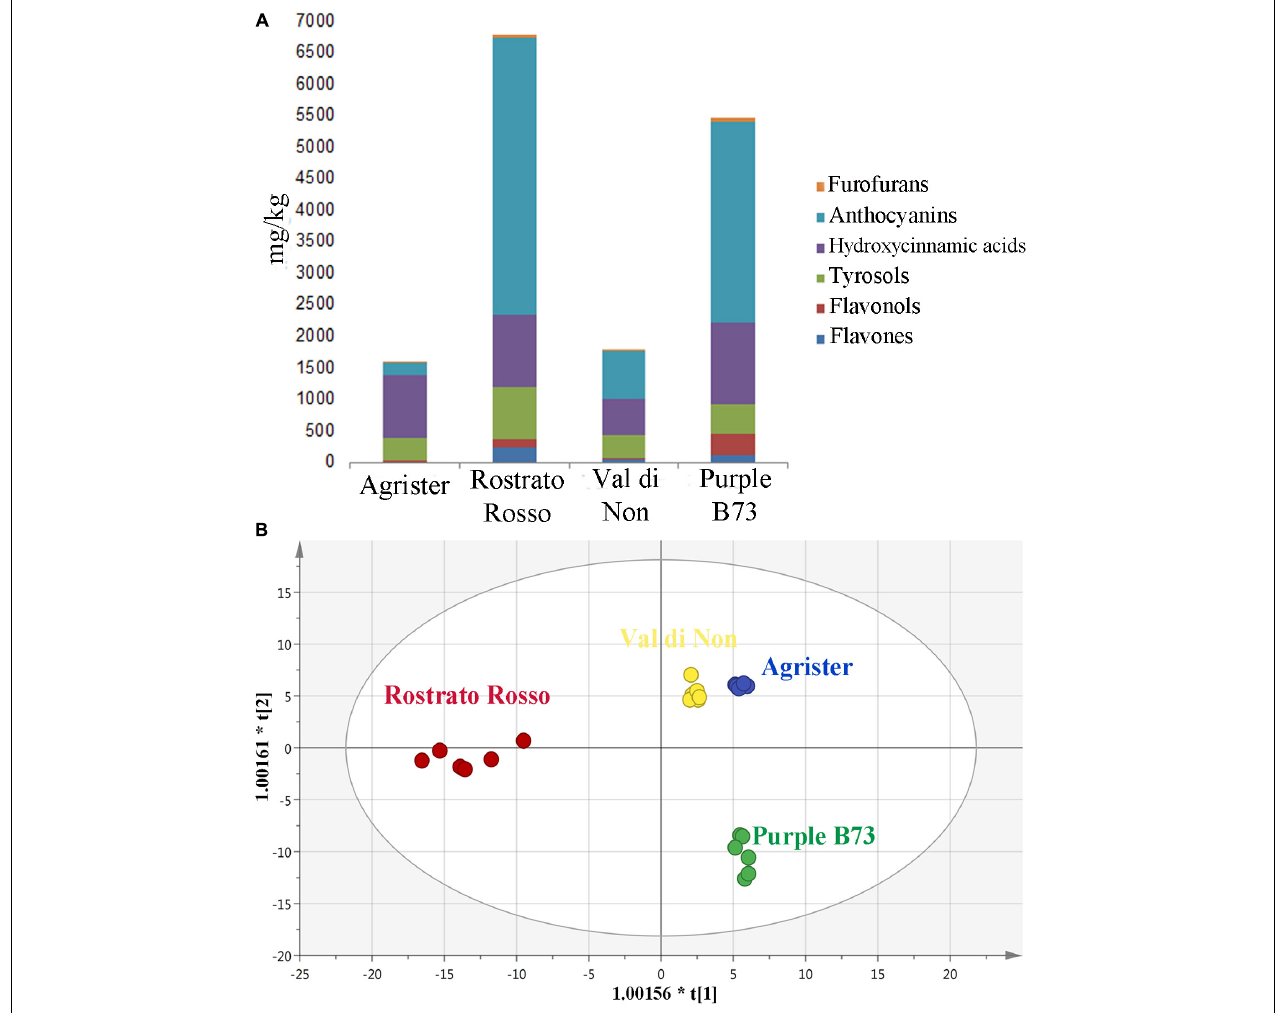
FIGURE 4 | (A) Cumulative abundance, expressed as mg kg − 1 equivalents, of the different phenolic subclasses in the analyzed maize genotypes, as gained from UHPLC-ESI/QTOF-MS screening analysis. (B) Orthogonal Projections to Latent Structures Discriminant Analysis (OPLS-DA) on maize genotypes according to their phenolic profile. Individual replications are given in the class prediction model score